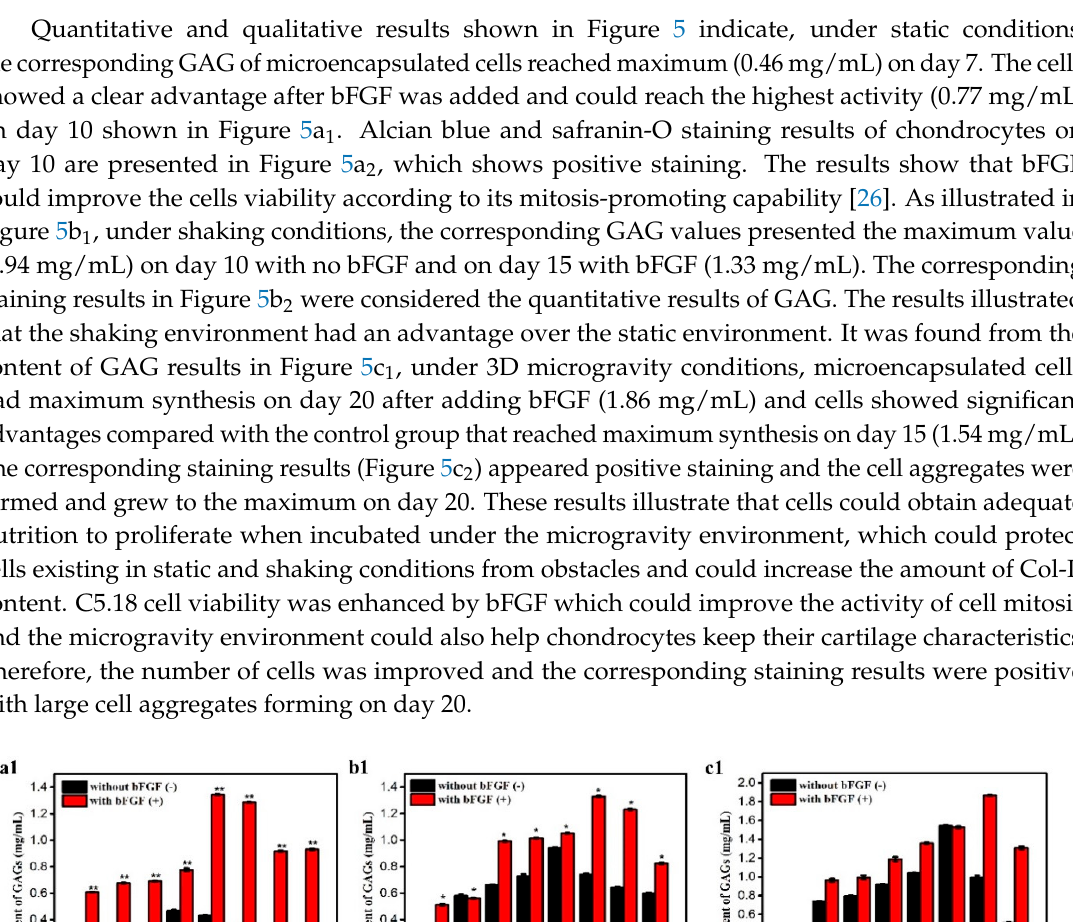
Figure 4. Proliferation of artificial cells under different culture conditions: ( a ), Static, ( b ) shaking, and ( c ) RCCS (** p < 0.01, * p < 0.05).